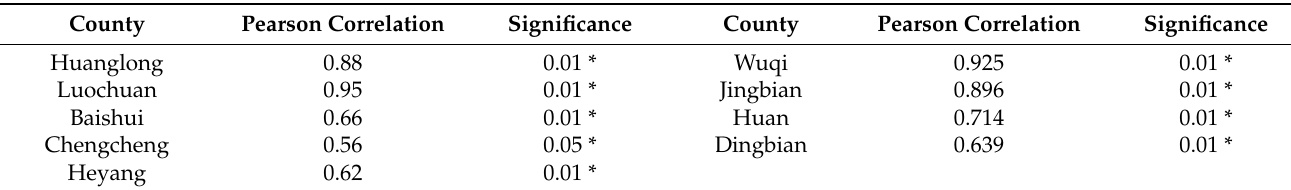
Table 2. Correlation between FVC and afforestation engineering intensity in typical areas. * indi- cates the significance of the correlation test. 0.01 * represents a significant correlation at the 0.01 level. 0.05 * represents a significant correlation at the 0.05 level.